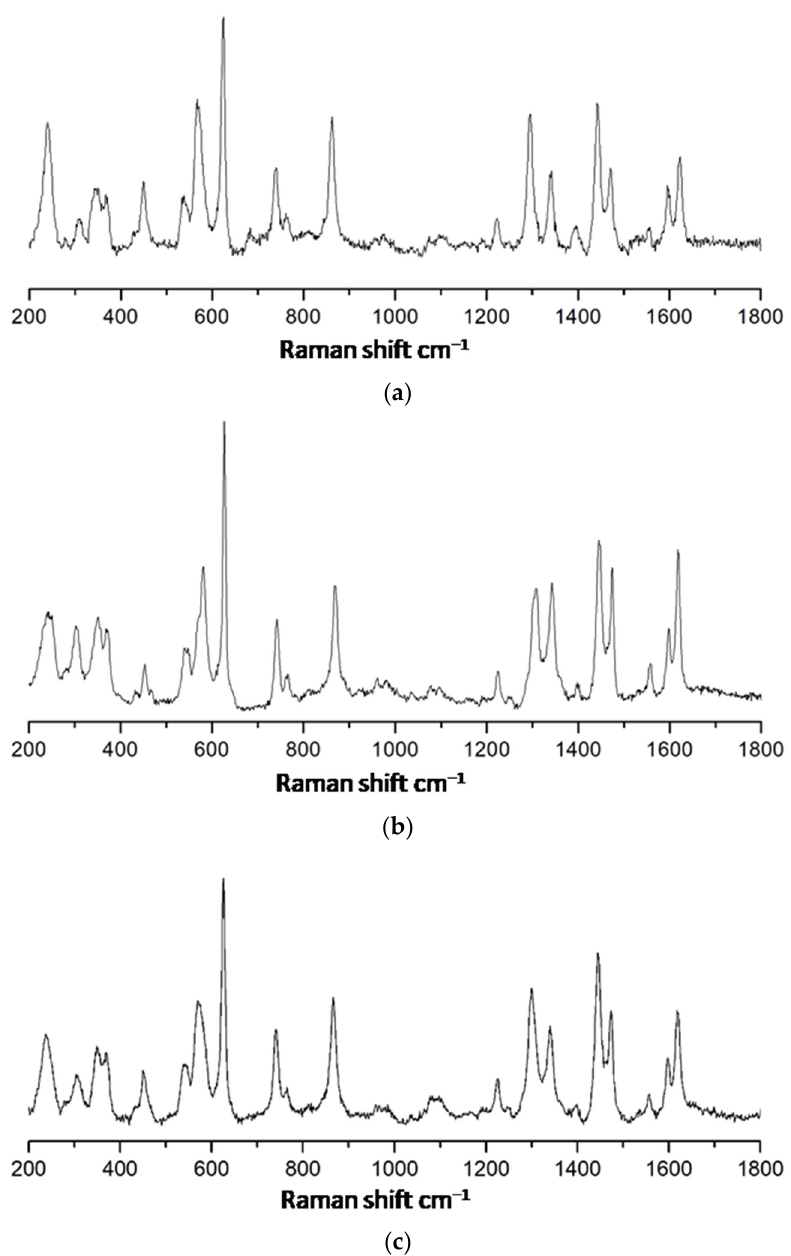
Figure 9. Room temperature Raman spectra of the alkylated compounds ( 10 )–( 12 ), ( a – c ), after excitation at 633 nm.